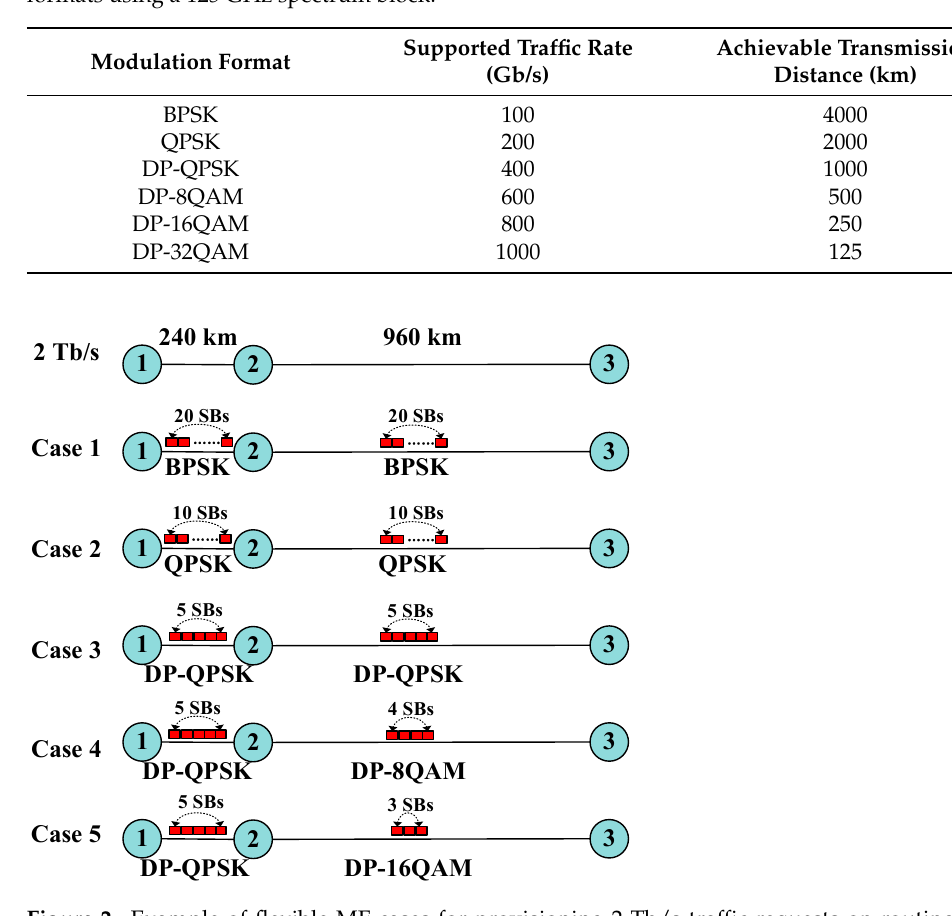
Figure 2. Example of flexible MF cases for provisioning 2 Tb/s traffic requests on routing path 1 → 2 → 3.